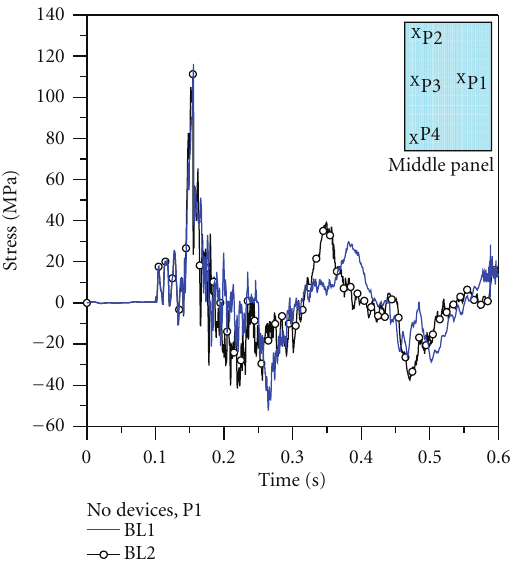
Figure 5: Comparison of maximum tensile stresses at location P1, as a function of time (ABAQUS). No devices. M01 FE-model, BL1 and BL2.